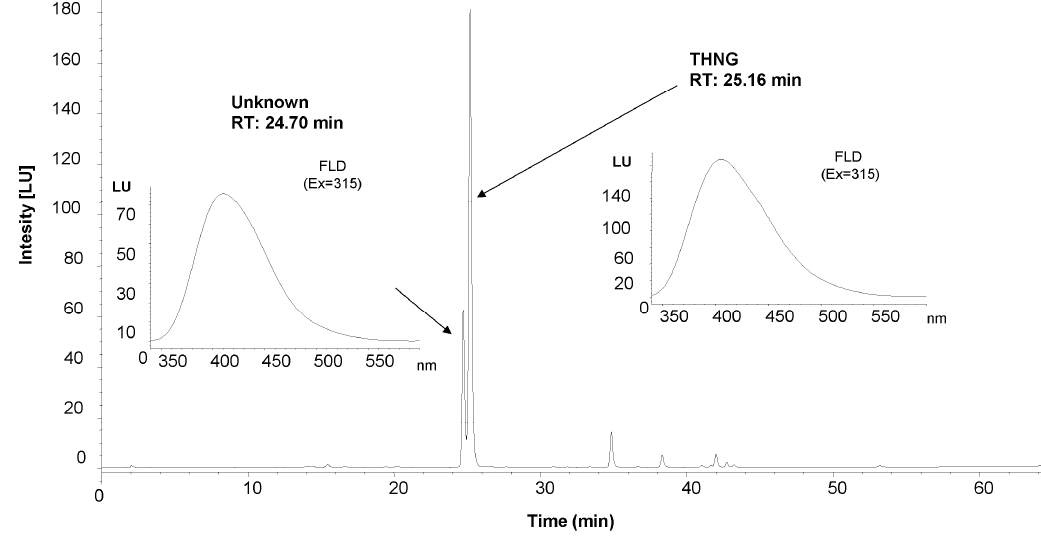
Figure 6. HPLC chromatographic profile of the fresh flower methanolic extract of Impatiens glandulifera Royle with FLD